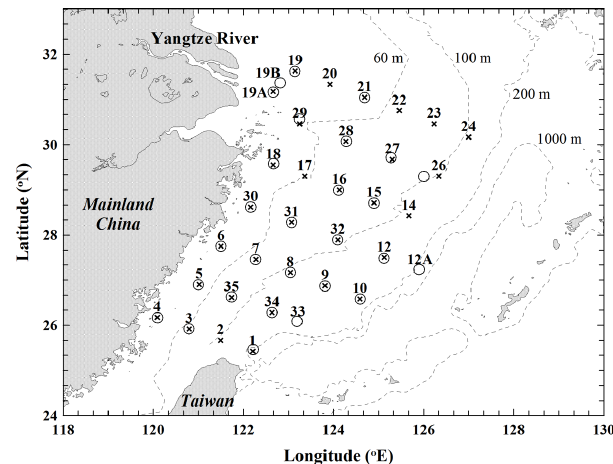
Fig. 1. Map of stations in the spring of 2009 ( × ) and 2010 ( (cid:13) ) in the East China Sea (ECS) with the station number above the mark. Bottom depth contours (dashed lines; 60, 100, 200 and 1000m) are also shown; this is also the case in Figs. 2, 3, and